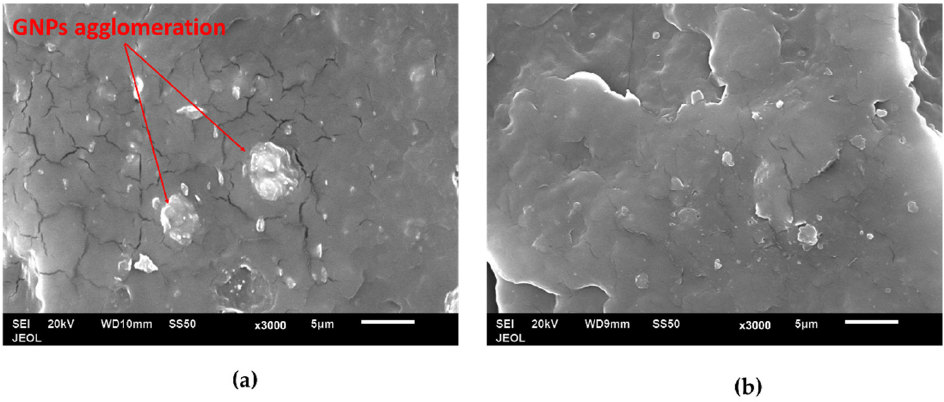
Figure 7. SEM images of 5 wt. % of GNP of PP/5GNP composites of ( a ) PP3 and ( b ) PP23.